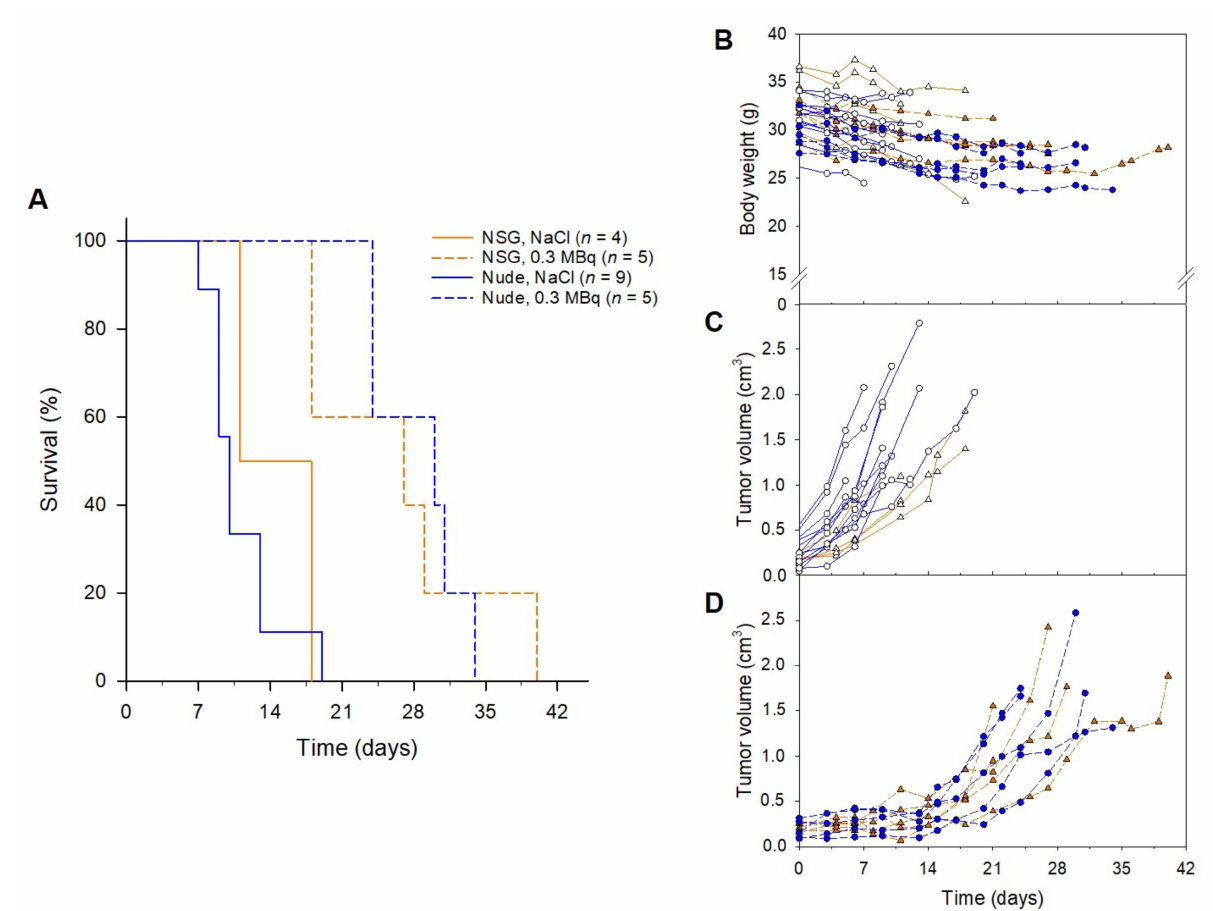
Figure 3. ( A ) Survival, ( B ) body weight and ( C , D ) tumor growth of NSG and athymic nude mice bearing human prostate PC-3 PIP tumors treated with ( C ) saline or ( D ) 0.3 MBq of 212 Pb-NG001. Survival was estimated by Kaplan–Meier survival analysis followed by log-rank test by pairwise comparisons. n , number of mice per